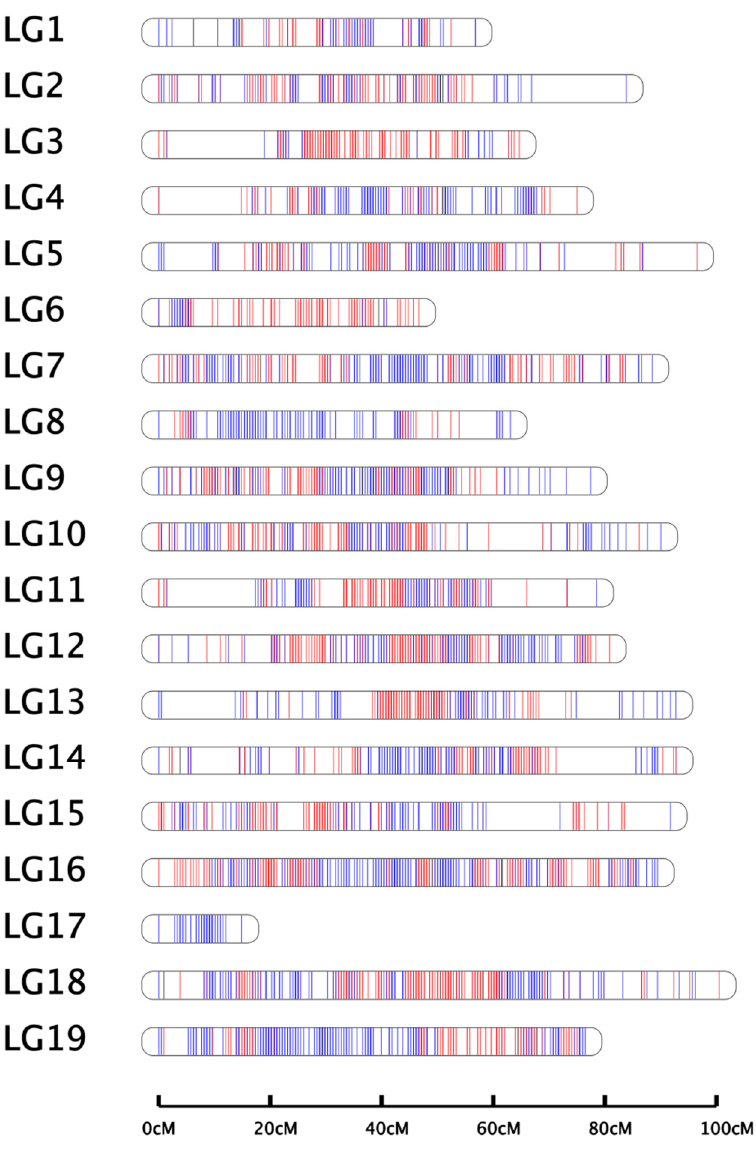
Figure 2. Integrated linkage groups for Muscat Hamburg × Crimson Seedless. Paternal sites are indicated in red, maternal sites are indicated in blue, heterozygous loci are indicated in black. The linkage groups were numbered according to acknowledged references (PN40024 assembly 12X) [61].